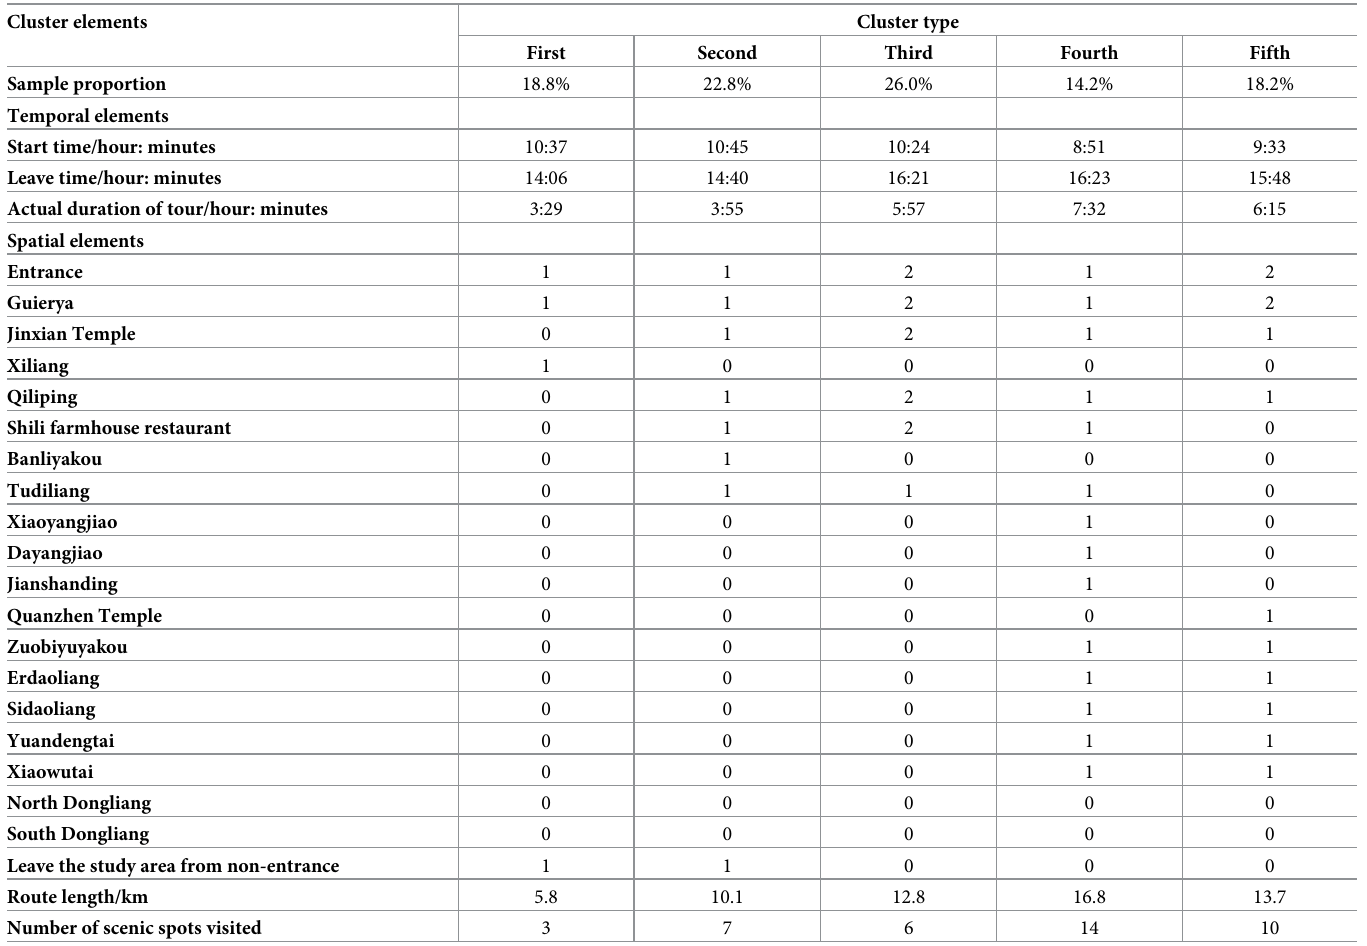
Table 2. Cluster analysis